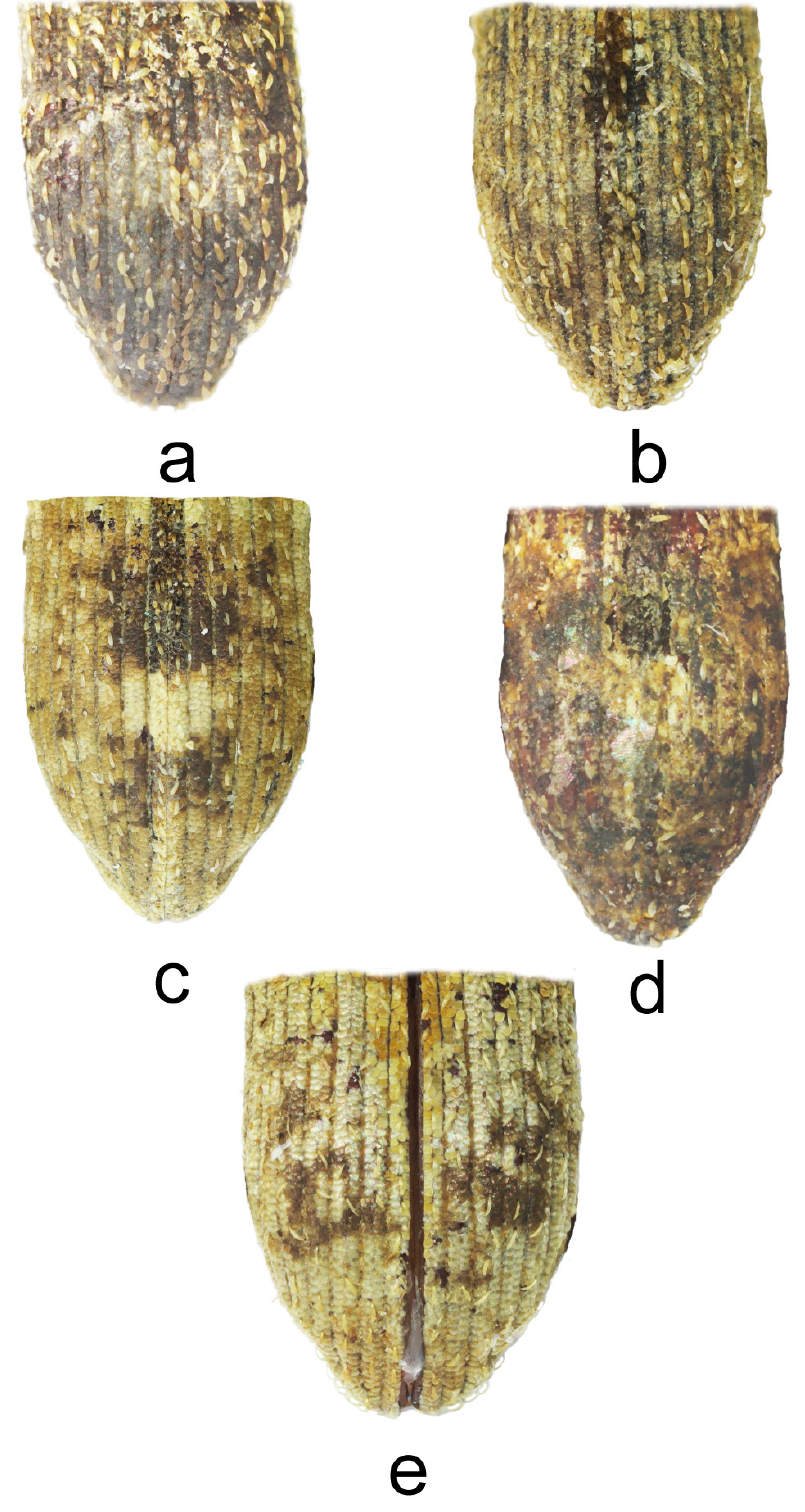
Figure 3. Scales on elytra of ( a ) Afroryzophilus djibai ; ( b ) A. centrafricanus ; ( c ) A. kuscheli ; ( d ) A. congoanus ; ( e ) A. somalicus. (Not at the same scale).